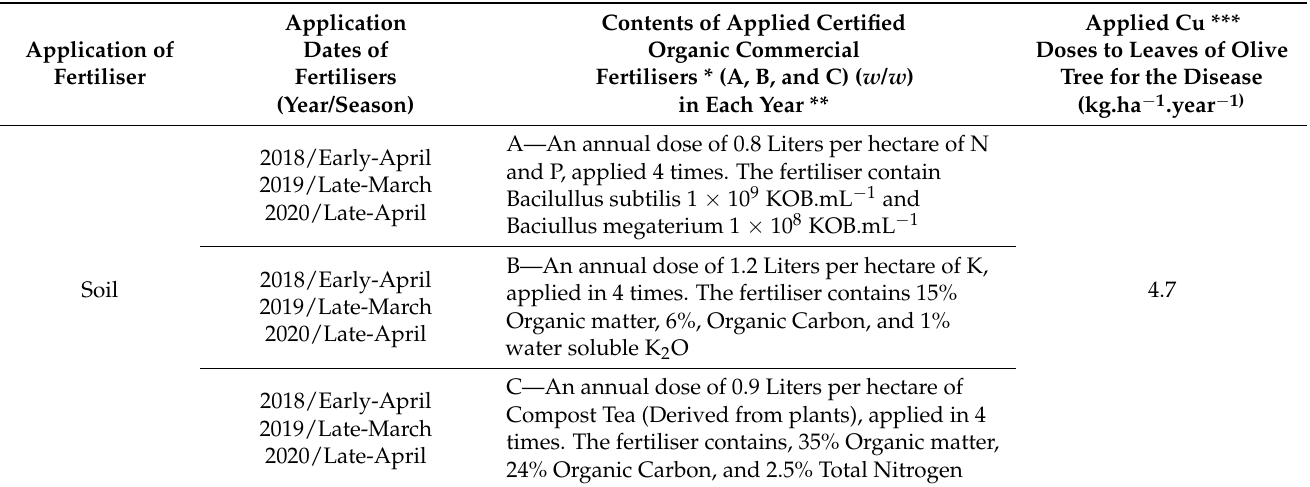
Table 1. Fertilisation programme of the copper trial.